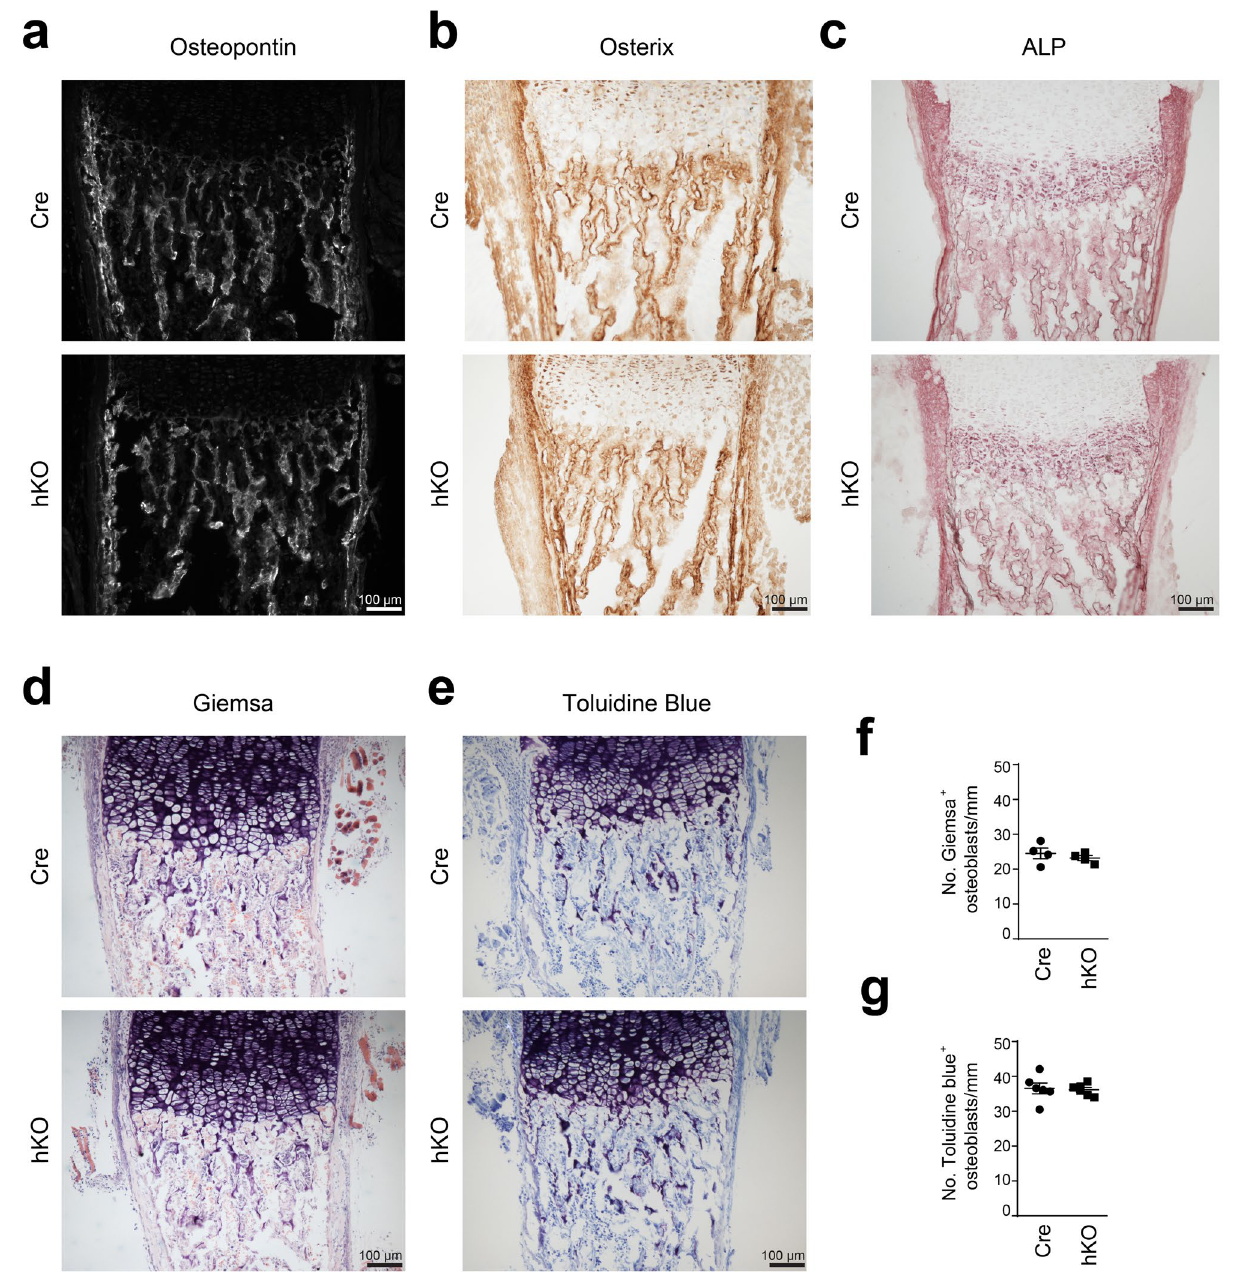
Figure 3. Characterization of osteoblast organization in femoral sections from Mirc24 cluster-deficient mice. Osteoblast distribution in plane matched sections of femora from newborn male Col2a1-Cre (Cre) and Col2a1-Cre- Mirc24 tm1M/Y (hKO) mice was analyzed by immunodetection of ( a ) osteopontin and ( b ) osterix. ( c ) In addition, alkaline phosphatase (ALP) activity was detected by histological staining. ( d , e ) To determine osteoblast numbers, paraffin sections were stained with Giemsa and Toluidine Blue. Brightness was adjusted using Adobe Photoshop Elements 2020 (Version 18.0, https:// www. adobe. com/ produ cts/ photo shop- eleme nts. html) for visualization ( d , e ). At least three animals per genotype were analyzed and representative images are shown. Additional images are shown in Supplementary Figs. S3 and S4 online. ( f , g ) For quantification, the number of Giemsa + and Toluidine Blue + osteoblasts per mm trabecular bone were determined. Individual and mean values and standard deviations are shown (graph). The figure was created using Adobe Illustrator CS6 (Version 16.0.3, https:// adobe. com/ produ cts/ illus